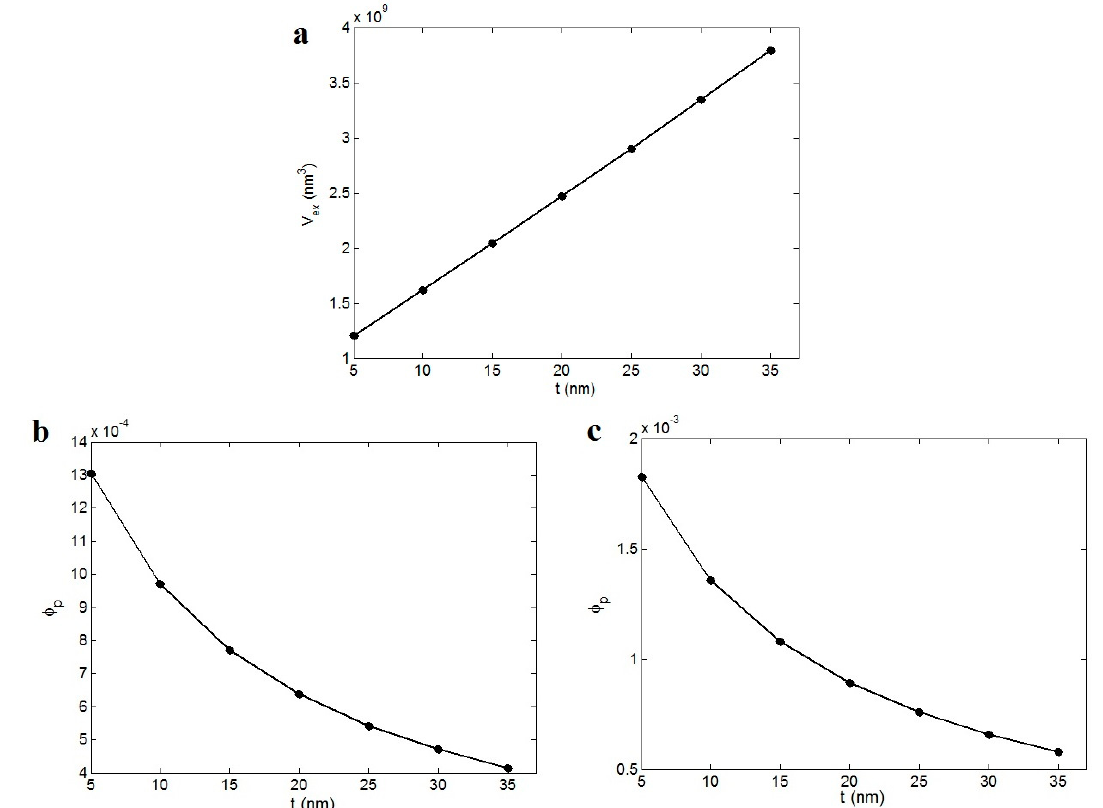
Figure 5. The effects of the interphase thickness on ( a ) excluded volume and the percolation threshold of nanoparticles according to ( b ) Equation (7) and ( c ) Equation (10) at R = 10 nm and l = 5000 nm.